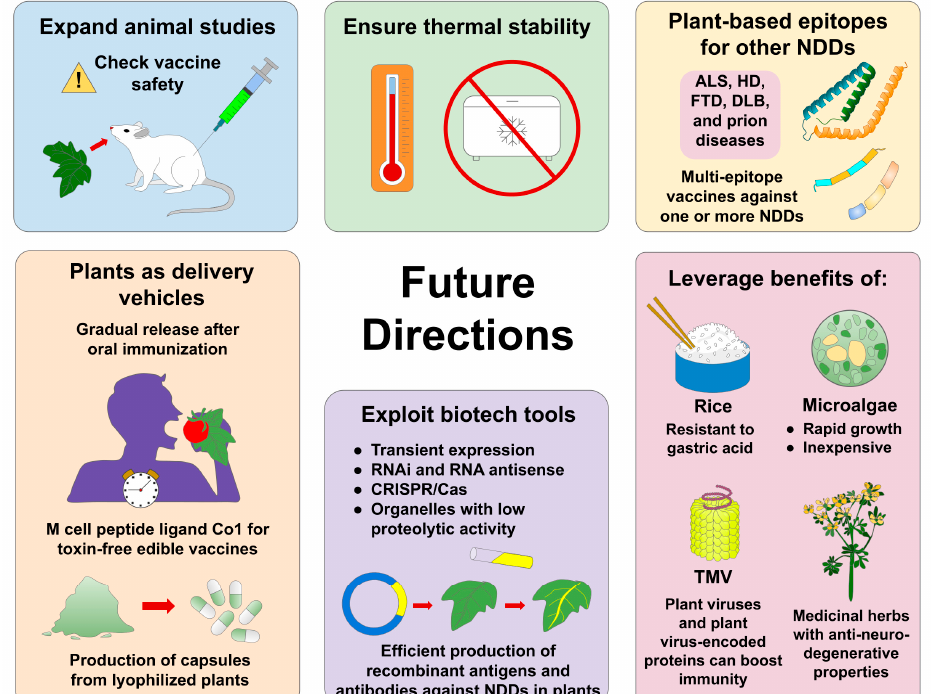
Figure 4. Future directions for the development of plant-based vaccines targeting NDDs. Extensive animal studies are required to ensure plant-derived vaccines’ safety. Furthermore, thermal stability studies should be performed to avoid the need for cold-chain transportation and storage. Additionally, future research should focus on developing plant-made vaccines against other NDDs and ex- ploring the possibility of combining different epitopes in a single vaccine to deal with multiple NDDs concurrently. One of the main advantages of plants is that they can serve as a delivery vehicle for pharmaceuticals, so this property must be taken advantage of and improved to facilitate antigen recognition in the immune cells of the digestive system. On the other hand, several biotechnological techniques could be harnessed with the aim of efficiently producing recombinant NDD-related an- tigens and antibodies in plants. Finally, upcoming investigations could leverage the advantages of systems such as rice, microalgae, plant viruses, and medicinal plants.